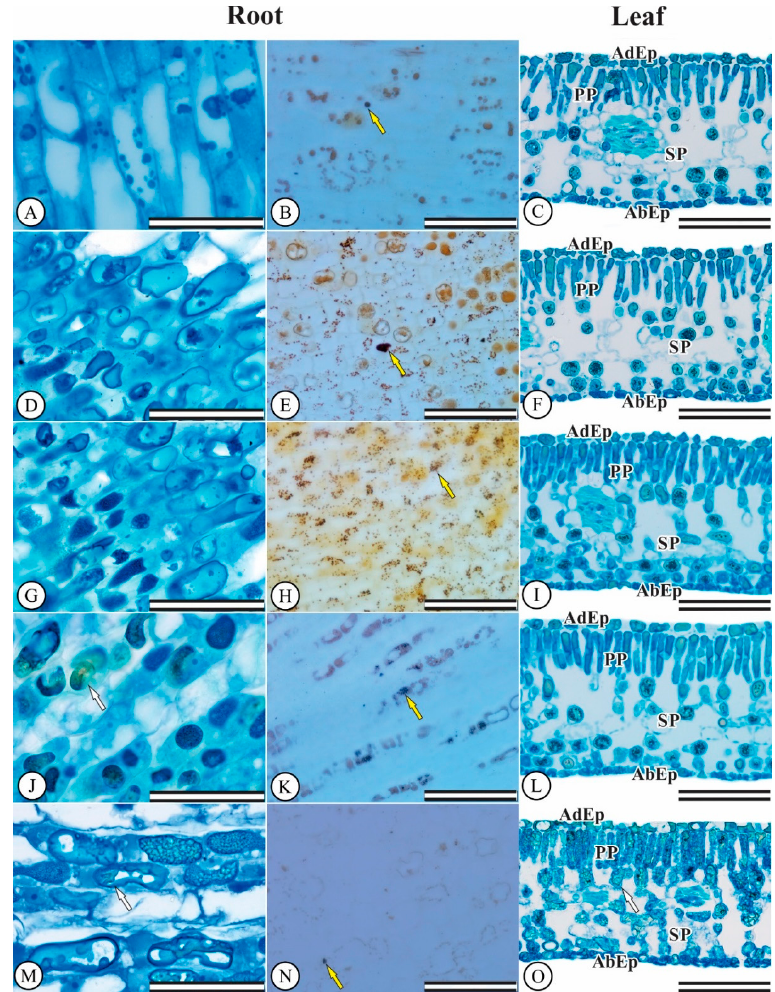
Figure 3. Eugenia dysenterica root and leaf anatomy after 20 days of growth at various Al concentrations. ( A – C ) control treatment, ( D – F ) 200 µ mol L − 1 Al 3 + , ( G – I ) 400 µ mol L − 1 Al 3 + , ( J – L ) 600 µ mol L − 1 Al 3 + , ( M , N , O ) 800 µ mol L − 1 Al 3 + . (AdEp) adaxial epidermis. (AbEp) abaxial epidermis. (PP) palisade parenchyma. (SP) spongy parenchyma. ( A , B , D , E , G , H , J , K , M , N ) root meristem and di ff erentiation zone. ( C , F , I , L , O ) leaf mesophyll cells. White arrows indicate the production of phenolic compounds and yellow arrows indicate starch accumulation. (First column) Scale bar = 50 µ m. (Second and third columns) Scale bar = 100 µ